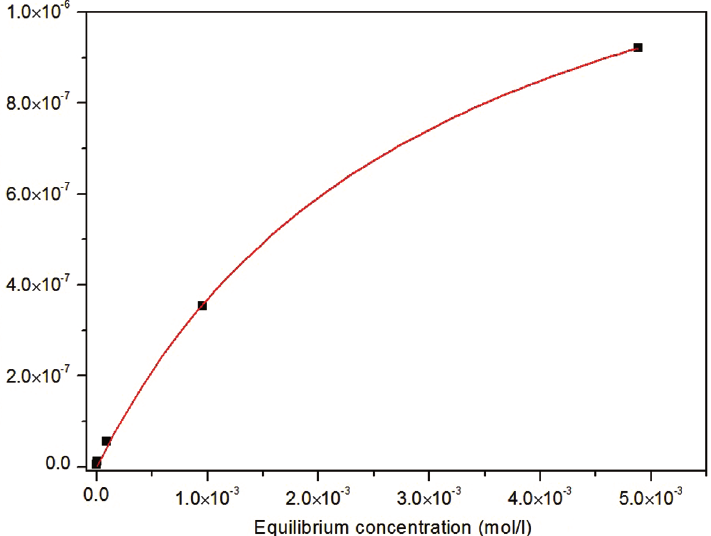
in Table 1 (parameters of the overall fit: R 2 = 0.9905, χ 2 = 1.88 × 10 -10 ).